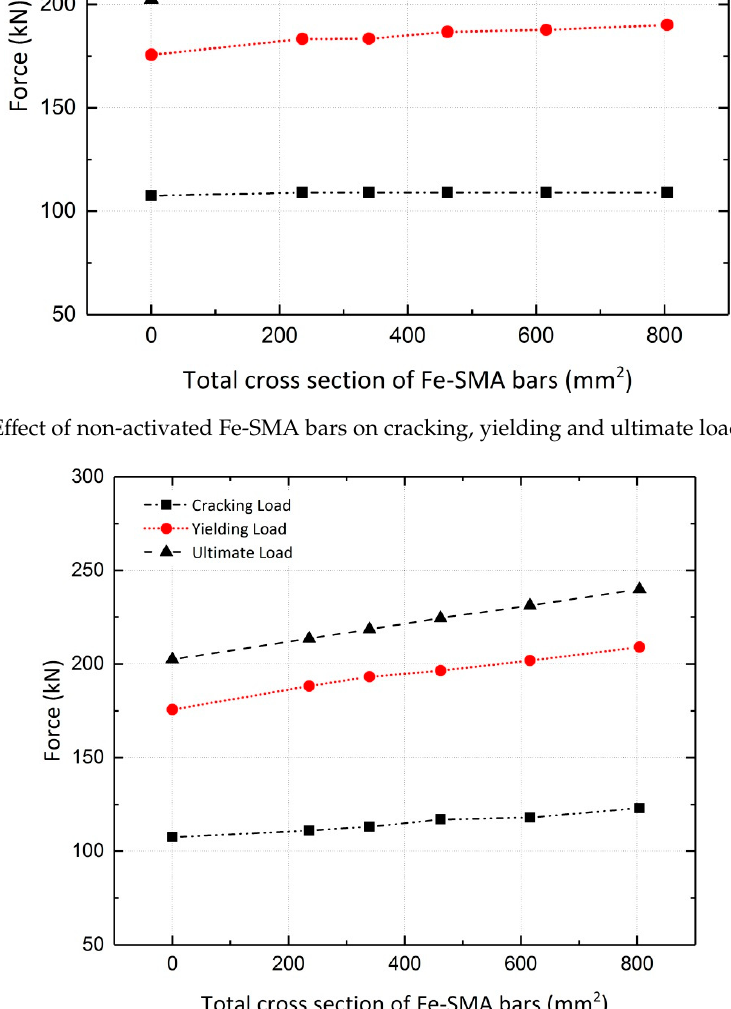
Figure 32. E ff ect of activated Fe-SMA bars on cracking, yielding and ultimate loads of Figure 32. Effect of activated Fe-SMA bars on cracking, yielding and ultimate loads of girders.